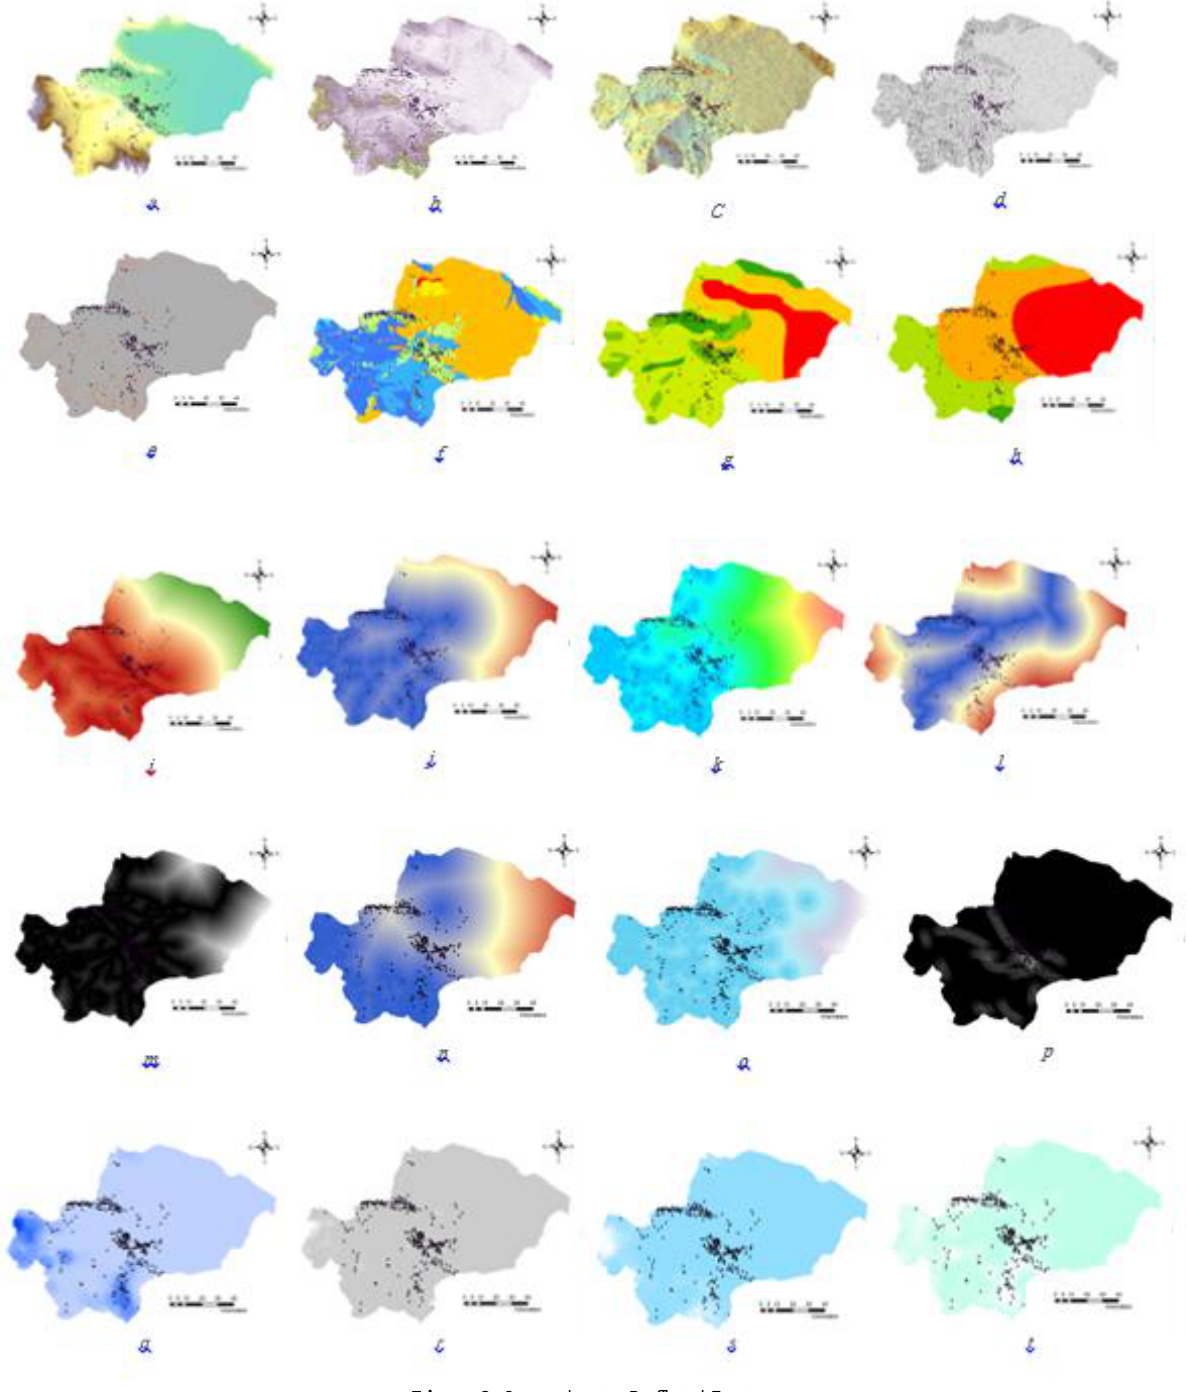
Figure 3 . Groundwater-Reflated